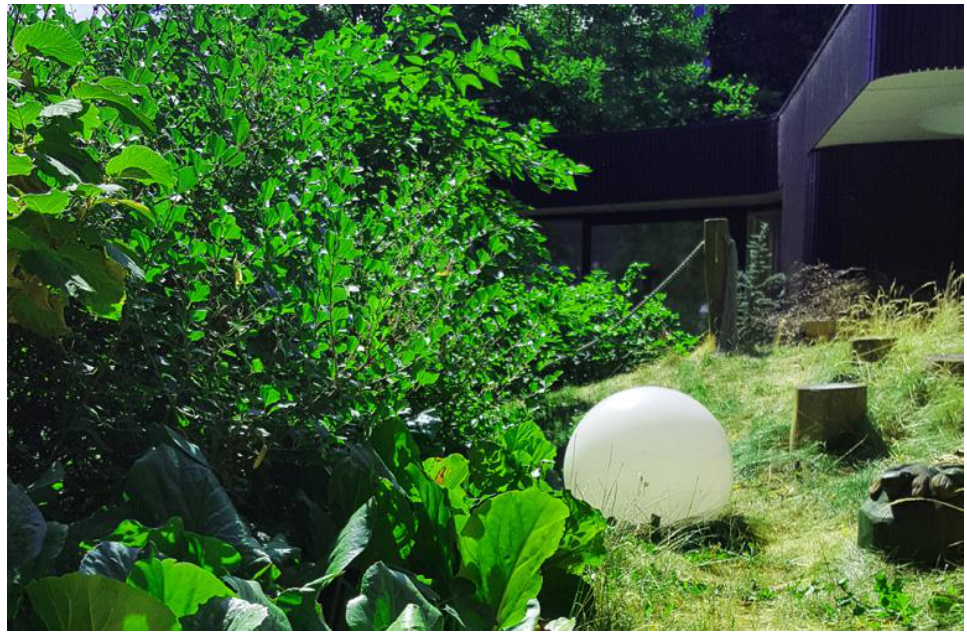
Figure 3. Dannerhuset Healing Garden, Denmark.